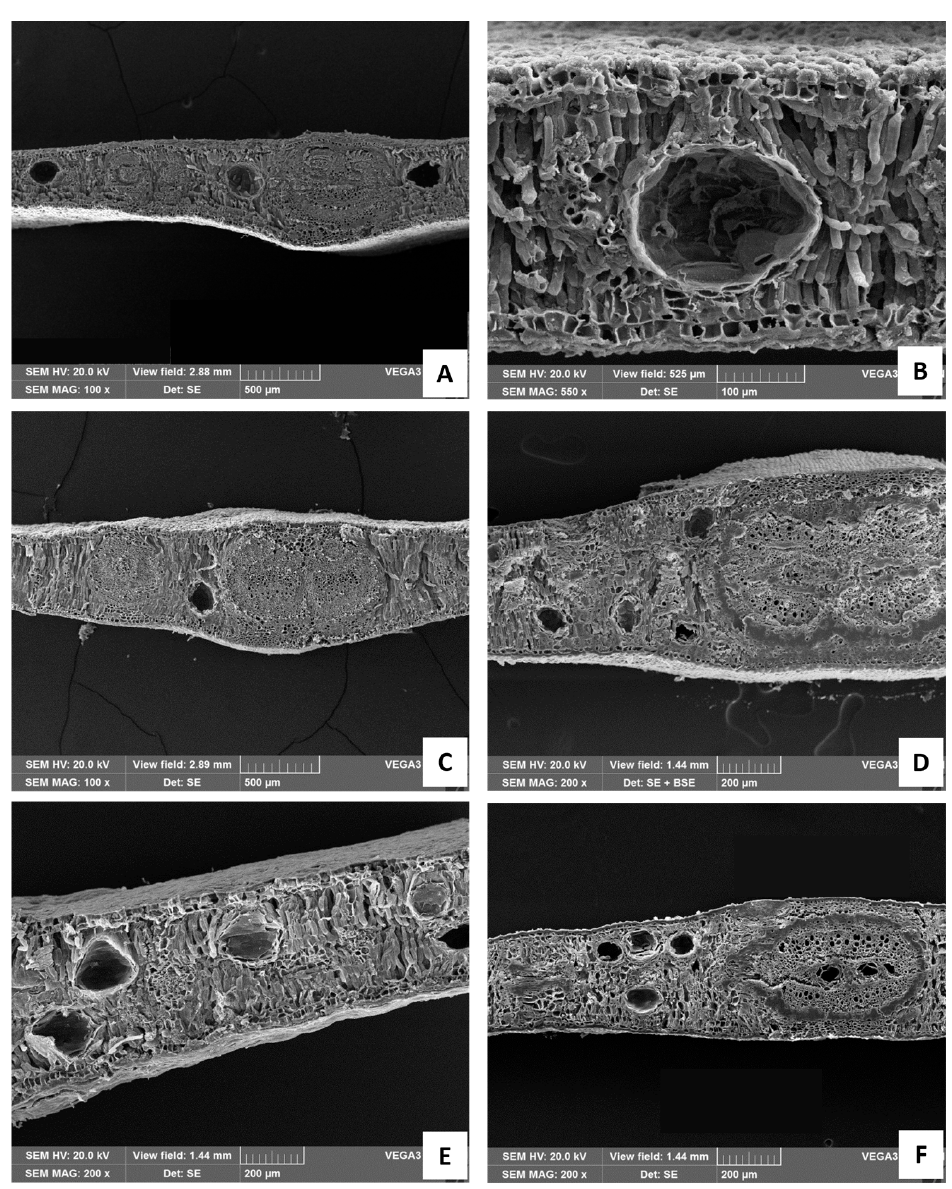
Figure 2. SEM micrographs of the transverse leaf sections of the five Eucalyptus species ( A – F ). The secretory cavities within the mesophyll are clearly visible in E. alba ( A ), and one secretory cavity at higher magnification is visible in the leaf of E. alba ( B ); E. eugenioides ( C ), E. fasciculosa ( D ), E. robusta ( E ), and E. stoatei ( F ).